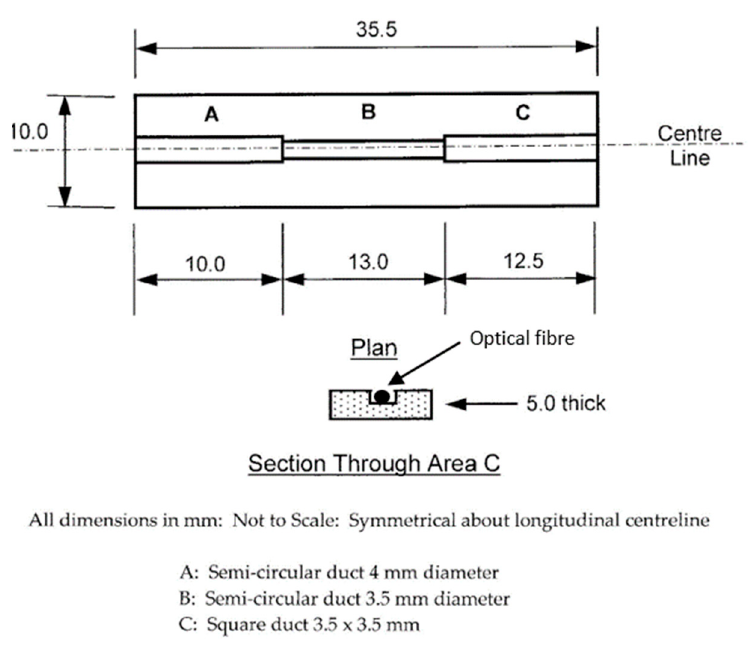
Figure 6. Layout of open-top package.